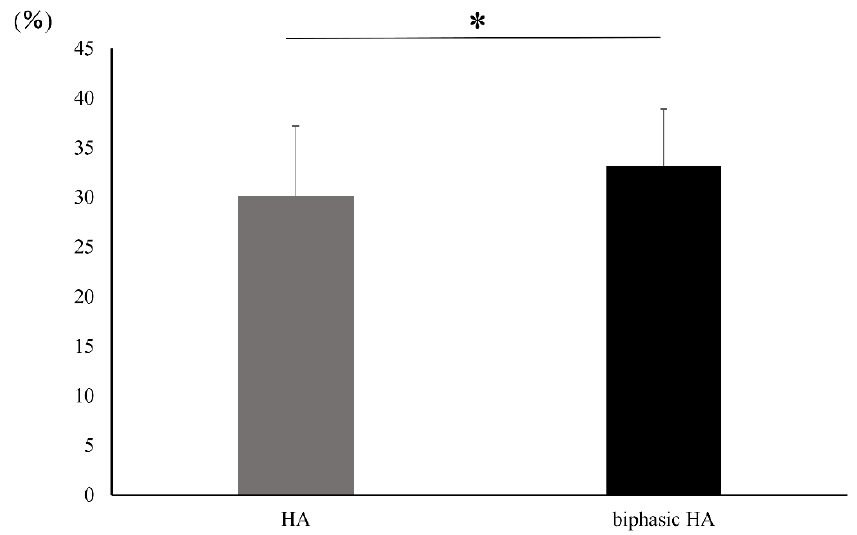
Figure 11. Volume ratio of newly formed bone in ROI (n = 7, * p < 0.05).